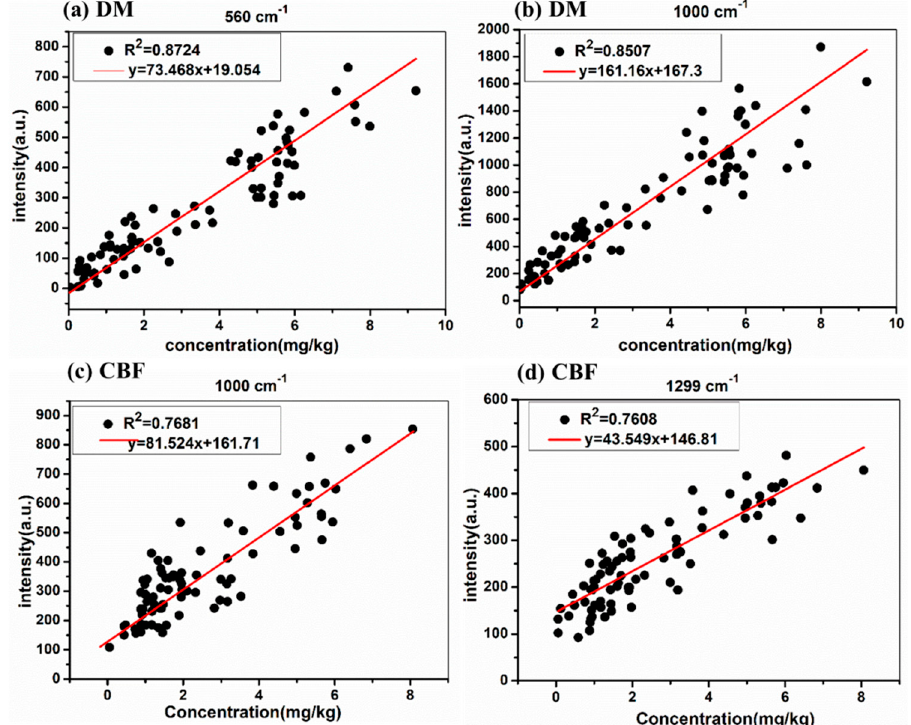
Figure 6. The linear equations of Raman characteristic peaks and its concentration of DM at 560 cm − 1 ( a ) and 1000 cm − 1 ( b ); the linear equations of Raman characteristic peaks and its concentration of CBF at 1000 cm − 1 ( c ) and 1299 cm − 1 ( d ).